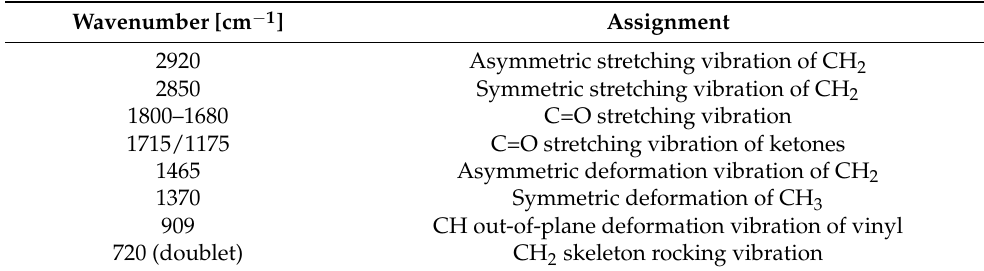
Table 5. Assignment of Fourier Transform Infrared (FT-IR) bands in POE spectra.